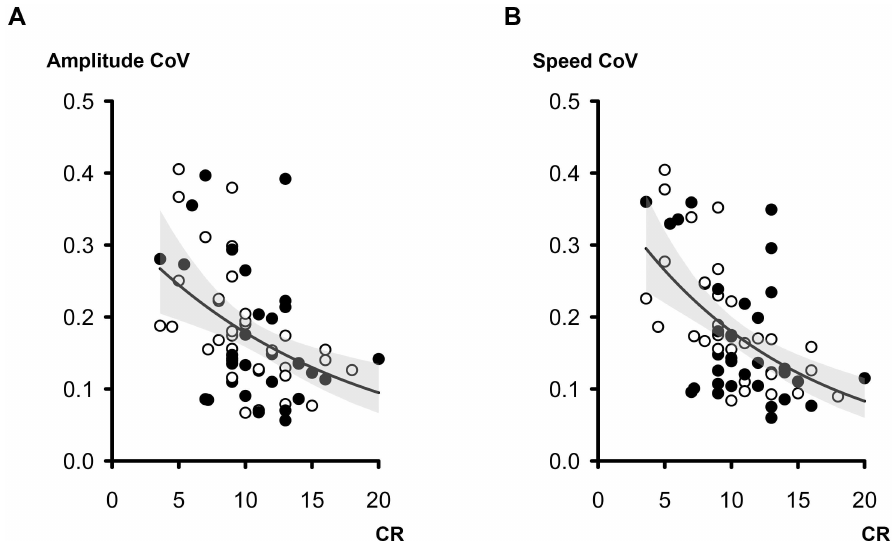
Fig 3. Scatter plots in the PD (A) and control (B) groups showing the relationship between CR scores and variabilities in amplitude and speed. Open circles represent the left side hand, and filled circles representthe right side hand. The fitted line representsthe predictedmean responsein the GEE model (predictor= TDT values, response= variabilitiesin amplitudeand speed), and the shadedarea indicates95% confidenceinterval. CR = coin rotation; CoV = coefficient of